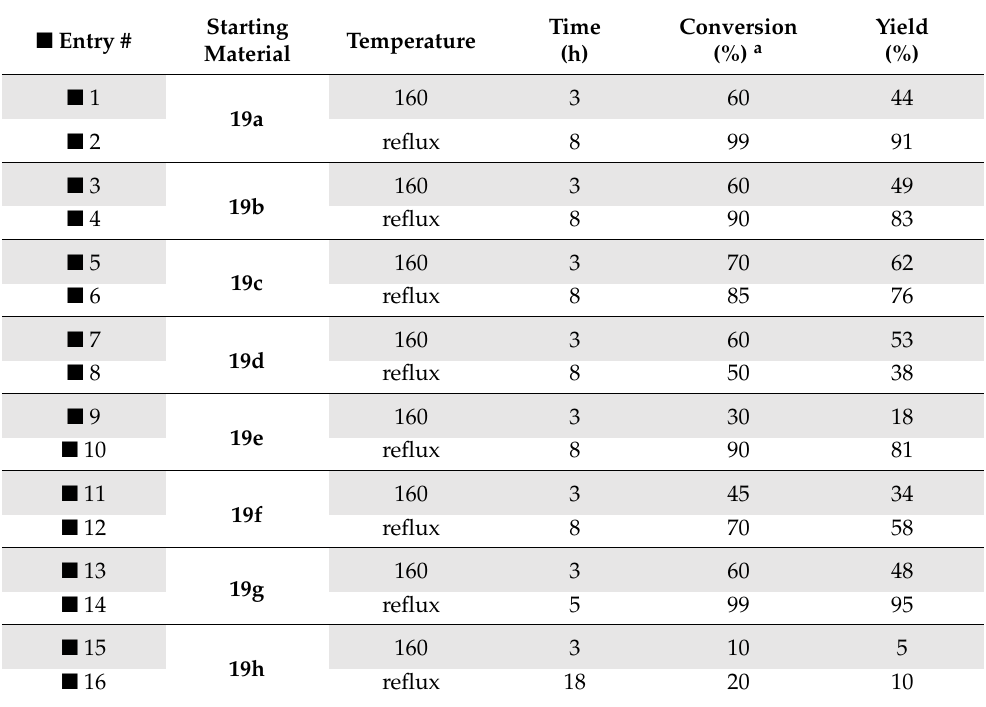
Table 2. Comparison of the reactivity of substituted KYNA derivatives 19a – h